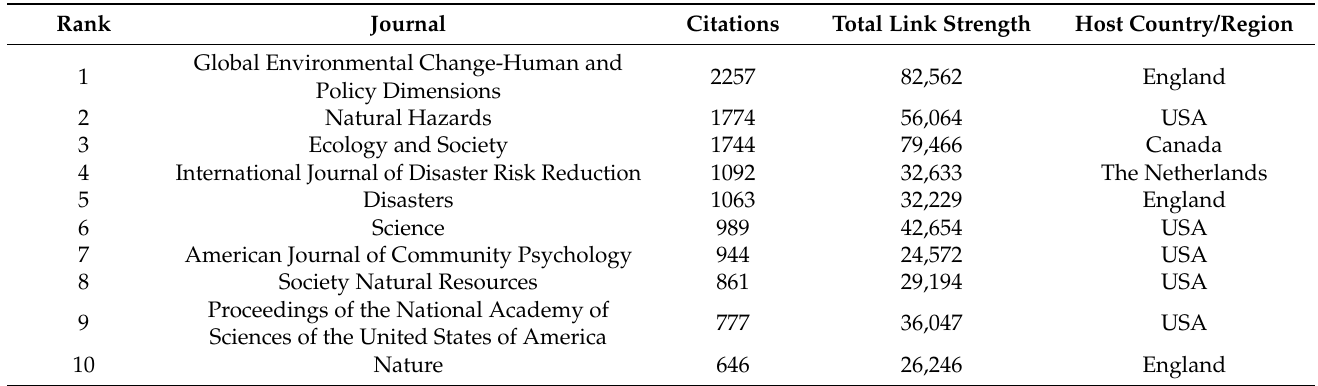
Figure 7. Network visualization map of co-citation journals in community research from 2001 to 2020. Note that the lines between the circles represents co-citation relationship. The thickness and number of connections between the nodes indicate the strength of links between journals. Table 4. Top 10 highly cited journals in community resilience research from 2001 to